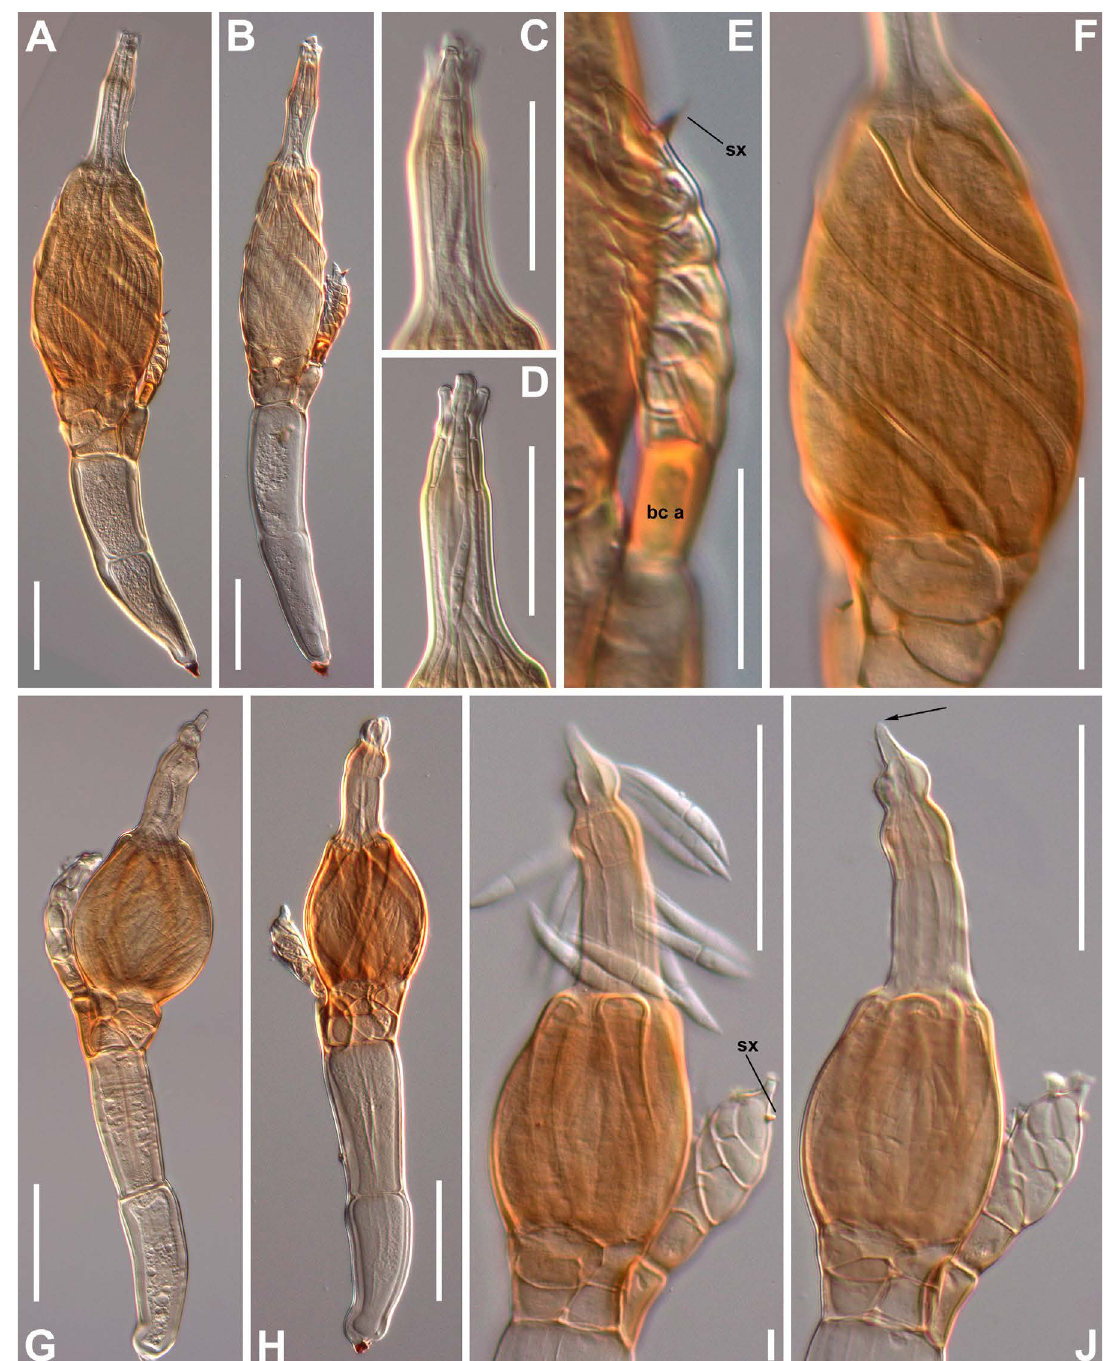
Fig. 59. Stigmatomyces spp. A – F . S. geomyzae W.Rossi & Cesari. A – B . Mature thalli. C – D . Perithecial tip in detail. E . Primary appendage in detail with labelled spinous process from the original spore apex (sx) and appendage basal cell (bc a). F . Perithecial outer wall cells in detail, arranged spirally and forming conspicuous ridges. – G – J . S. hydrelliae Thaxt. G – H . Mature thalli. I – J . Perithecium and appendage in detail at two different focus levels, showing spinous process from the original spore apex (sx) and pointed projection on the perithecial apex. Scale bars: A–D, F–J = 50 µm; E = 25 µm. Photographs from slides ZMUC C-F-123703 (A, C–F), ZMUC C-F-124024 (B), ZMUC C-F-123721 (G), ZMUC C-F-124032 262